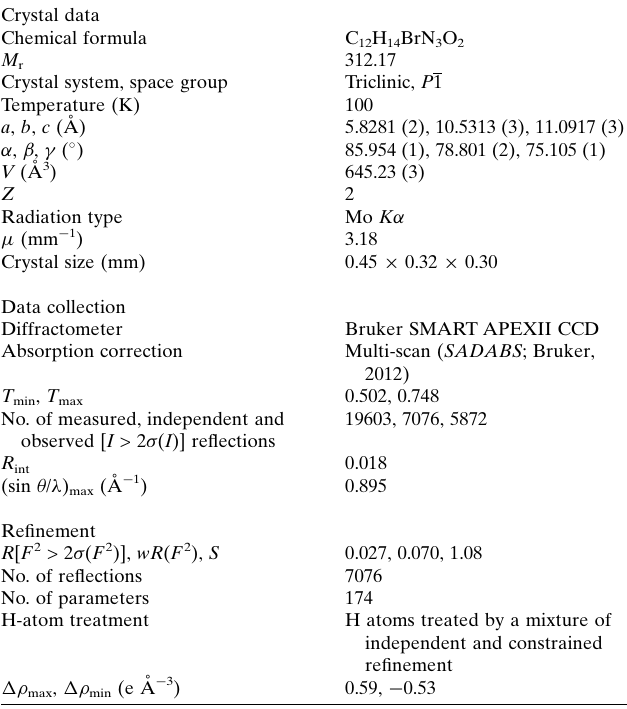
Table 2 Experimental